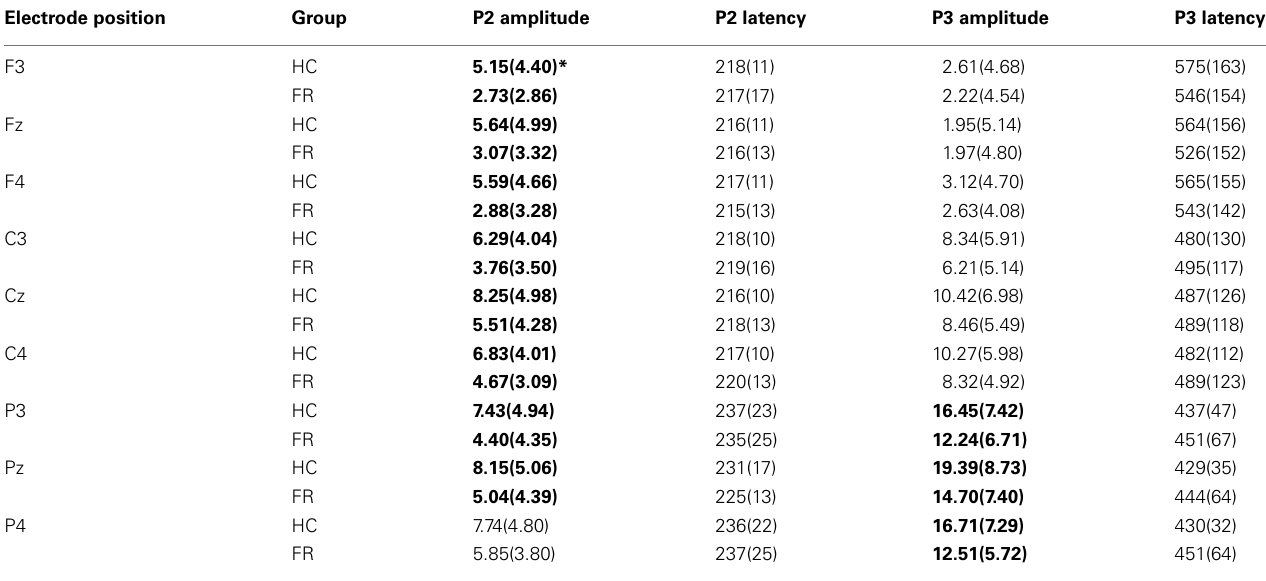
TableA1 | Means and SD (in parentheses) for ERP measures at nine electrode locations. Electrode position